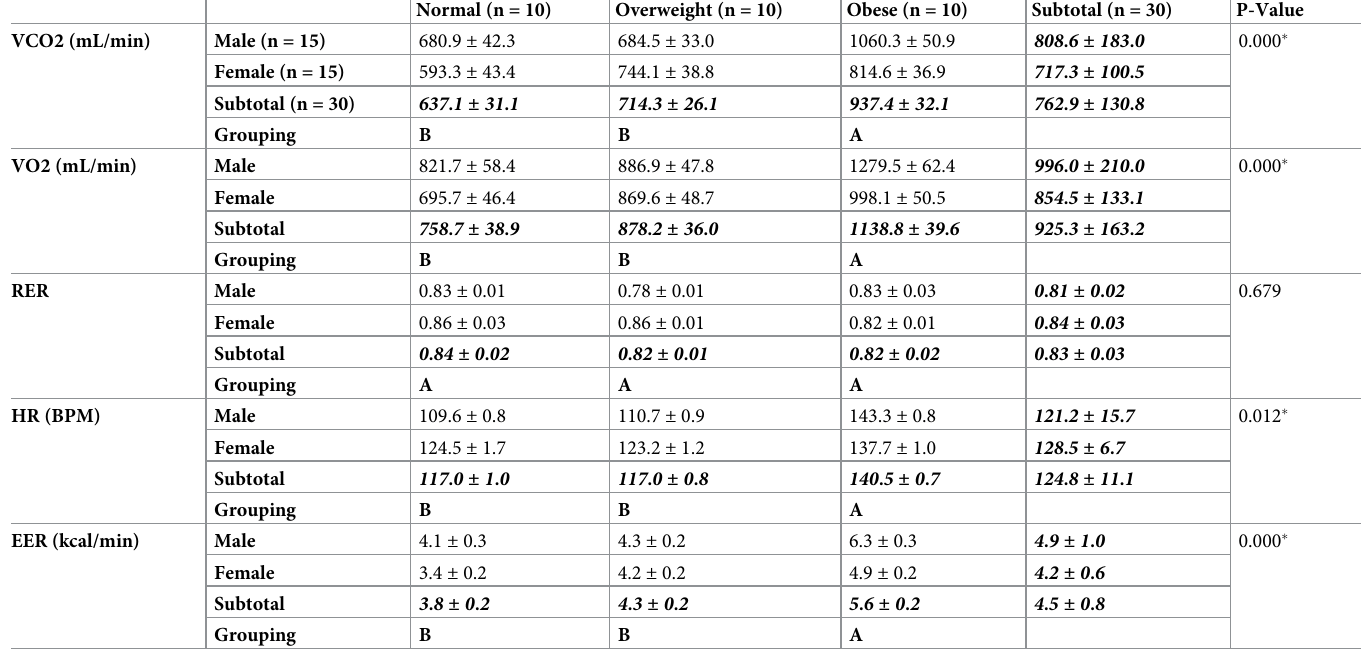
Table 5. Metabolic variables versus BMI and gender. Data are reported in terms the average value at the steady state of volume of carbon dioxide production (VCO2), volume of oxygen consumption (VO2), respiratory exchange ratio (RER), heart rate (HR), and energy expenditure rate (EER) in comparison to a subject’s BMI classifica- tion and gender. Marginal means ± standard deviation for BMI classifications are grouped using a Fisher Pairwise comparison. A p-value for the ANOVA test comparing each metabolic variable with BMI class is also reported, with ( � ) indicating statistically significant